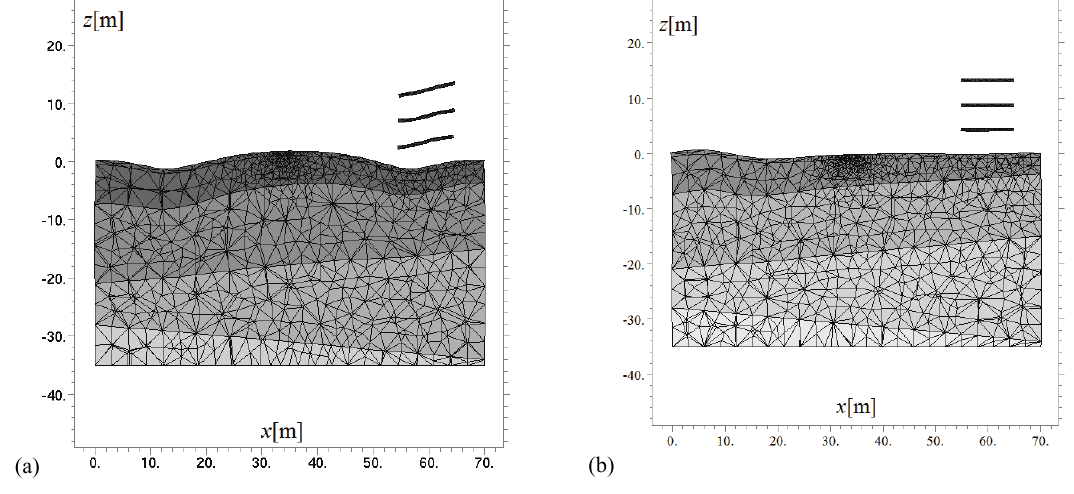
Fig. 3. Ground and structure deformation for y = 35 m, t = 0.125 s;